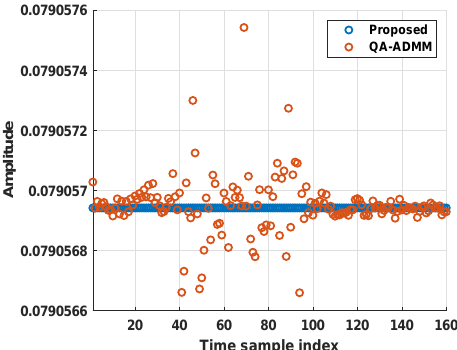
Figure 11. The modulus property of the designed waveform.